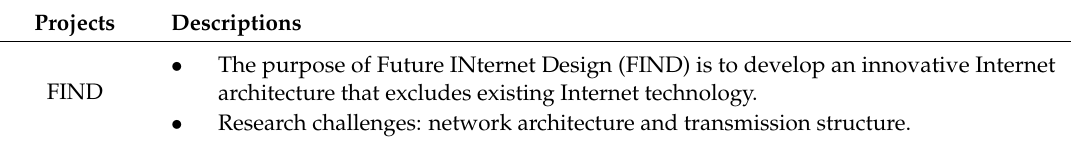
Table 2. The projects of the future network in the United